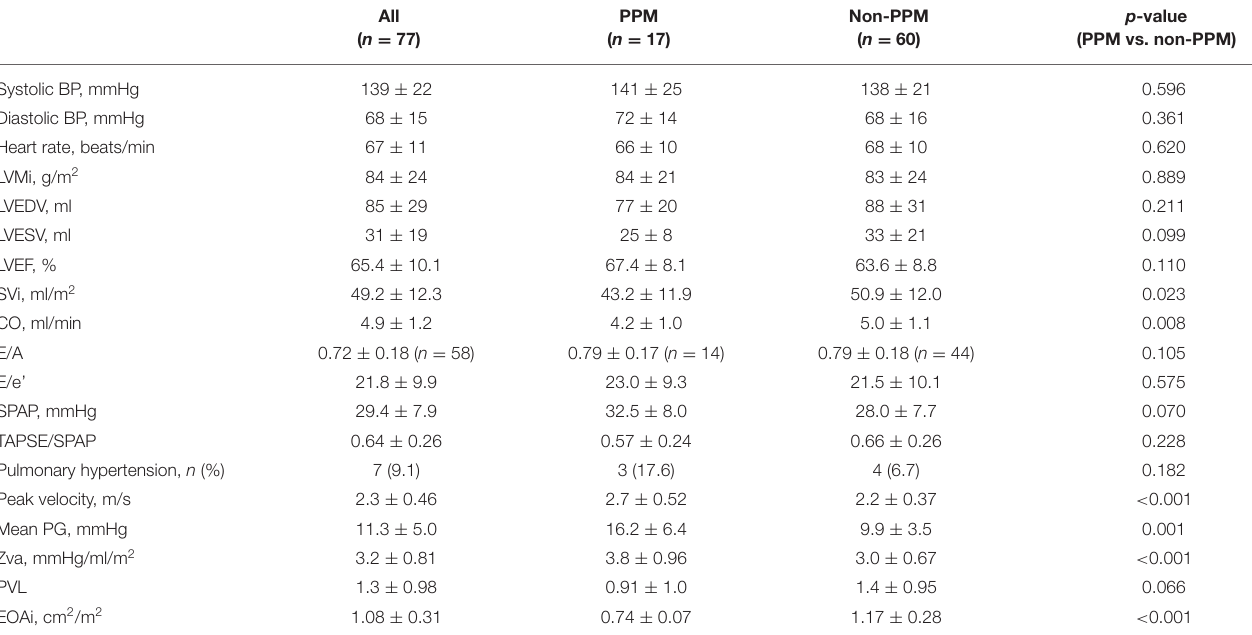
TABLE 3 | Resting echocardiography